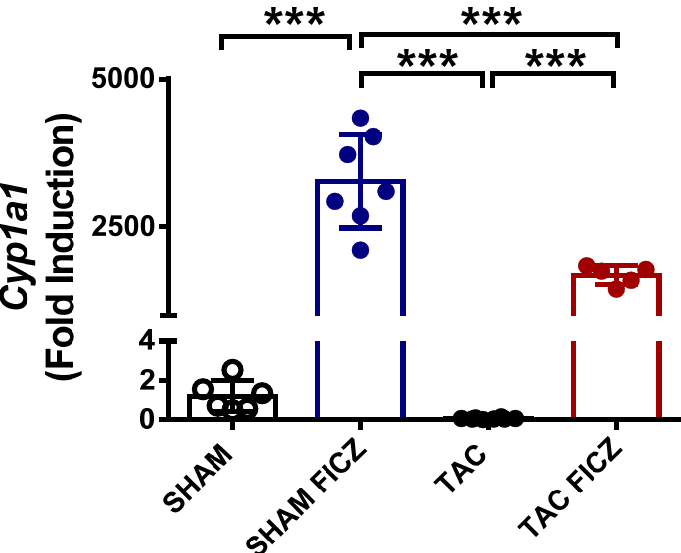
Figure 1. Formyl-indolo [3,2-b] carbazole (FICZ) treatment increases the expression of the aryl hydrocar- bon receptor target gene Cyp1a1 in heart tissue, evaluated by real-time PCR analysis. Groups are: Sham (open circles) ( N = 6), Sham FICZ (blue circles) ( N = 7), transverse aortic constriction (TAC) (black circles) ( N = 8) and TAC FICZ (red circles) ( N = 5). Data are expressed as mean ± SD. *** p < 0.001.